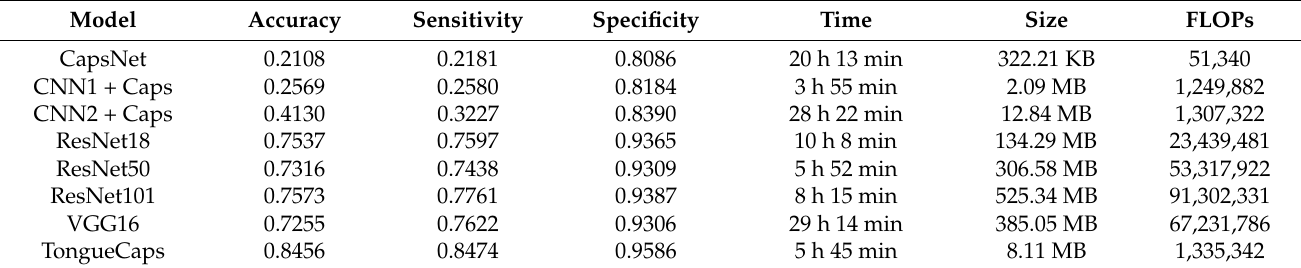
Table 5. Results of each